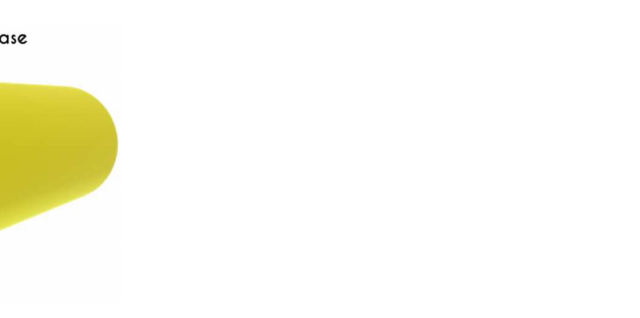
Figure 1. Schematic representation of a microtube of a radius R. It consists of a central RBC-rich region of radius δ , and an annular layer full of plasma and adjacent to the tube wall of thickness w = R − δ